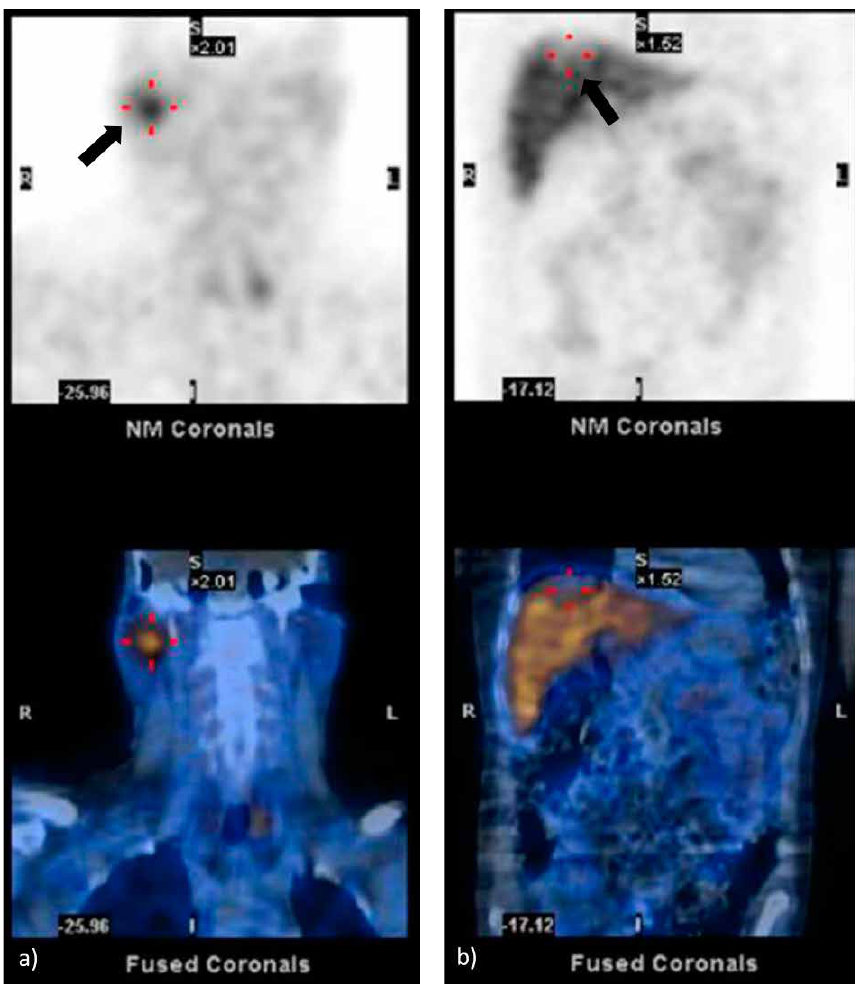
Figure 2: Octreoscan revealed increased uptake in the parotid gland (a) and mild expression in liver metastases